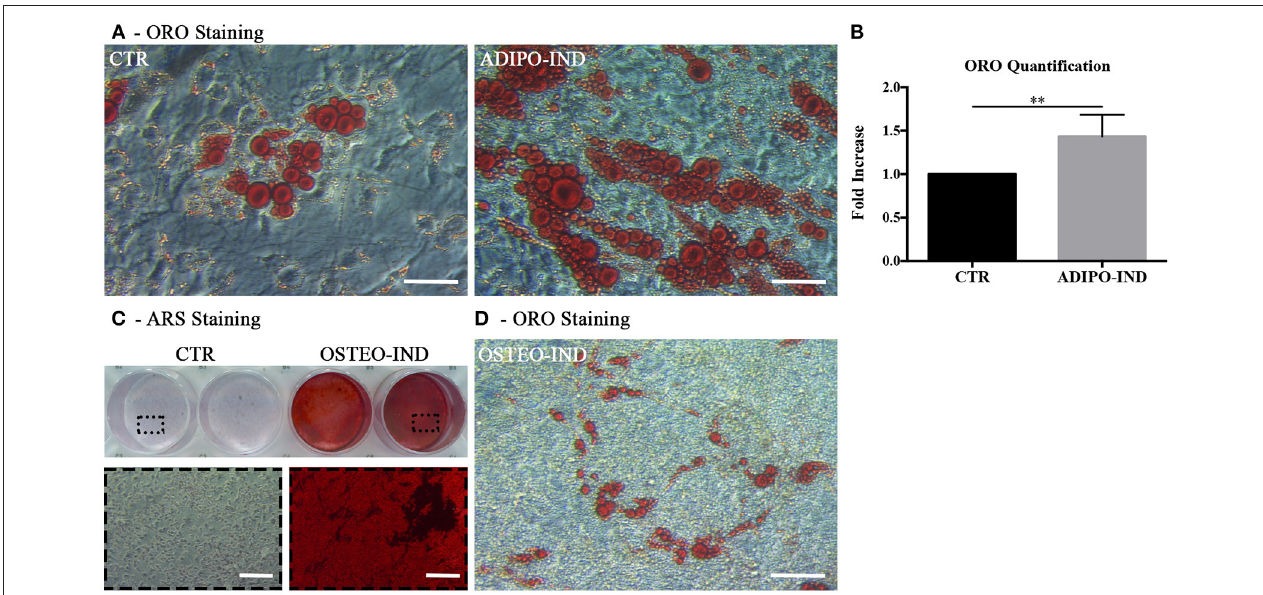
FIGURE 2 | Induction of adipogenic and osteogenic differentiation of HS-expanded hASC. (A) Representative ORO staining of adipogenesis-induced and control cells (scale bars = 50 µ m); (B) Quantification by spectrophotometric analysis of ORO dye incorporated in adipogenesis-induced and control (CTR) cells. Results are expressed as ratio referred to CTR value. Average values ± SD of 6 independent experiments, each one performed in triplicate, using cells either at passage 2 ( n = 3) or 5 ( n = 3) are reported. The ** symbol corresponds to p = 0.002; (C) Representative ARS staining of osteogenesis-induced and control cells. Lower images are magnifications of the highlighted areas (scale bars = 200 µ m); (D) Representative ORO staining of osteogenesis-induced cells (scale bars = 50 µ